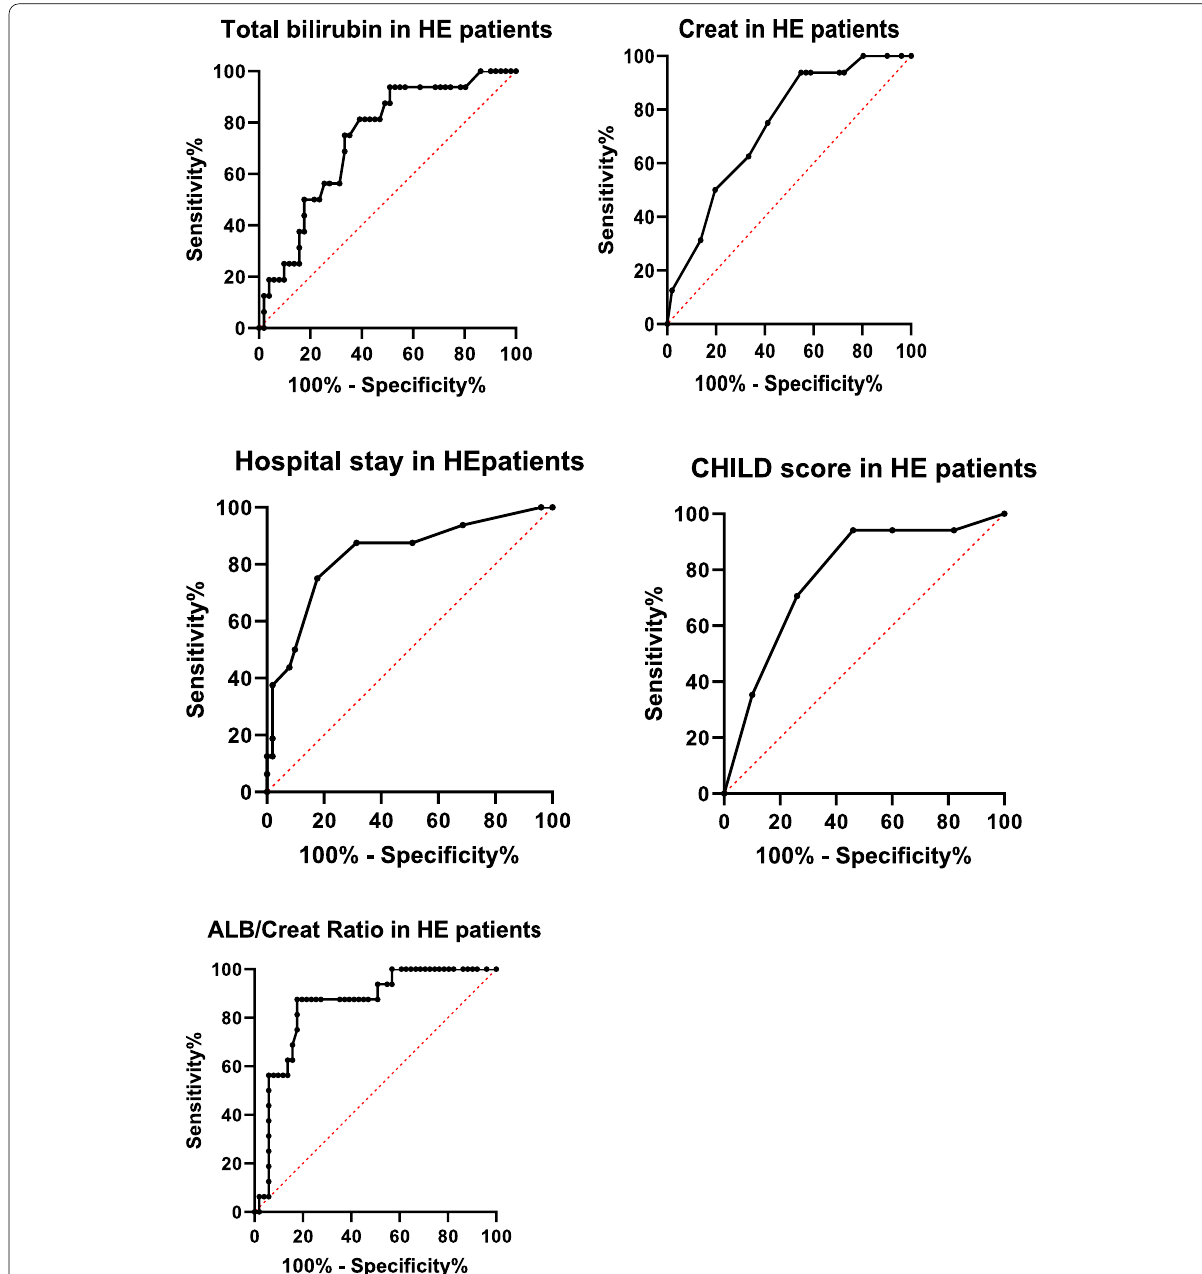
Fig. 1 Area under the receiver operating characteristic curve for predictors of